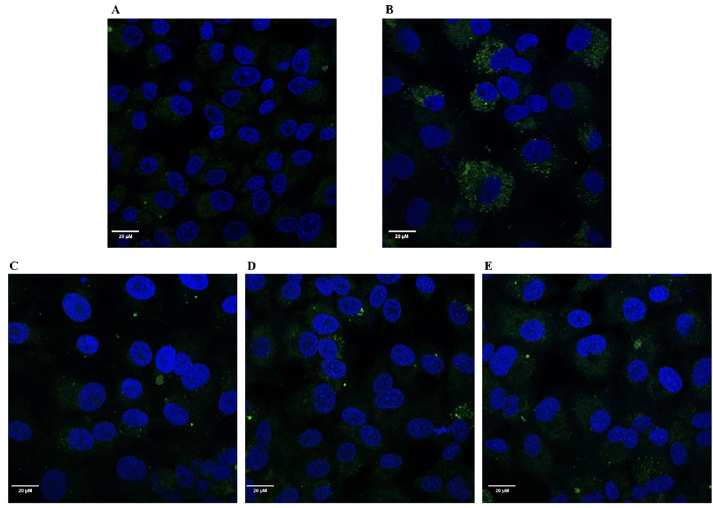
Figure 8. Confocal microscopy images of Vero E6 cells after immuno fl uorescence staining. A , Uninfected Vero E6 cells. B , Vero E6 cells infected with untreated dengue virus (DENV-2). Vero E6 cells infected with DENV-2 treated with saponin S1 ( C ), saponin S2 ( D ), and saponin S3 ( E ). DNA was counterstained with DAPI (blue fl uorescence). Scale bar 20 m